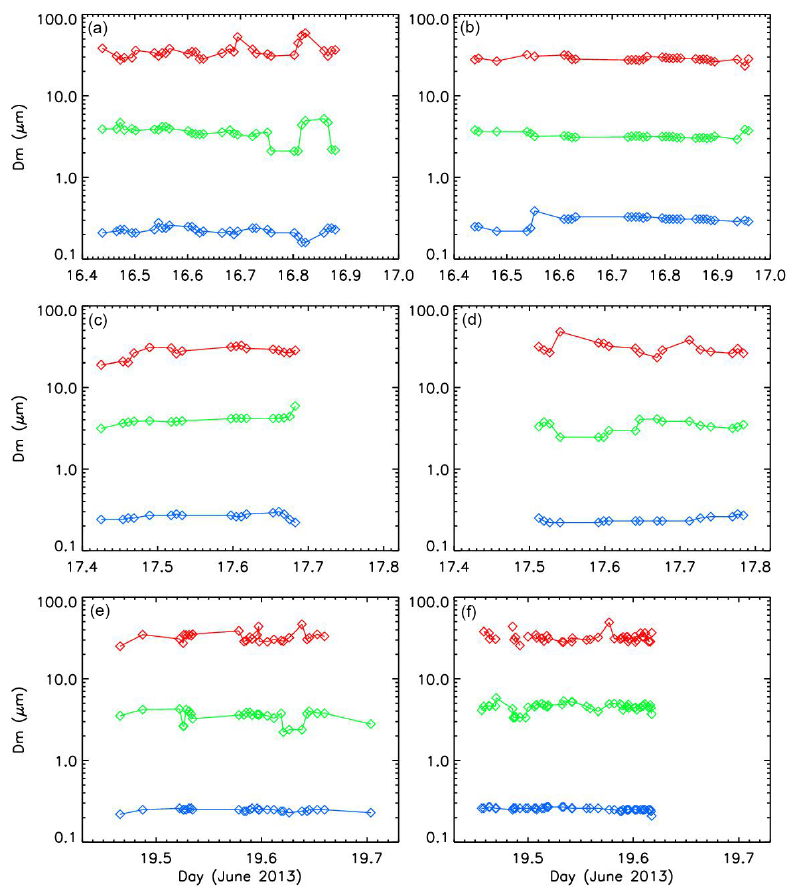
Figure 16. Time evolution of the particle size at the maximum concentration for each mode (Dm) of the volume size distribution, at float altitude of BLPB flights from Minorca towards the French coast. The altitudes are 2.1 and 3.1km for the 16 June flights ( a and b , respectively), 2.0 and 2.7km for the 17 June flights ( c and d , respectively), and 2.5 and 3.3km for the 19 June flights ( e and f , respectively). Average Dm values of the three modes during each flight are given in Table